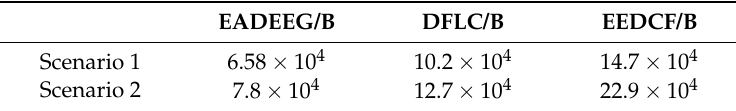
Figure 14. Data transmission in the network of the three algorithms in Scenario 2. Table 8. Data transmission in two scenarios.